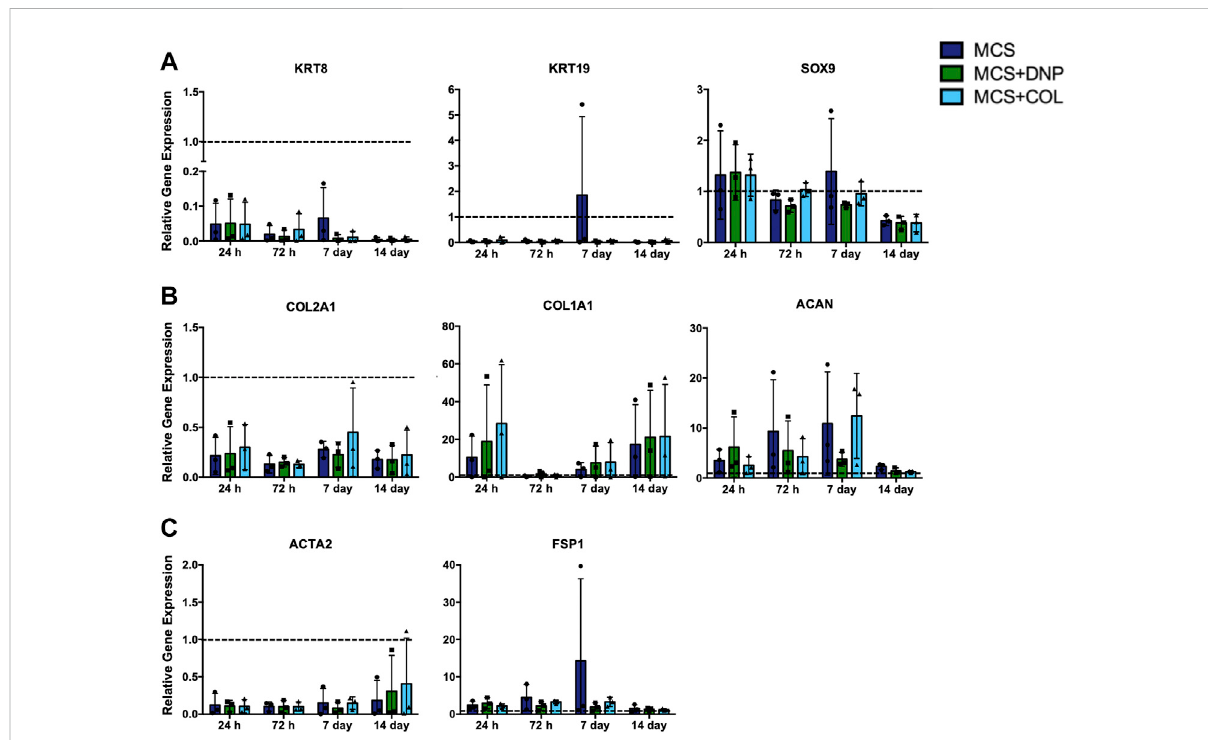
FIGURE 8 RT-qPCR geneexpressionanalysis of latepassageprimary bovine NPcells encapsulated within MCS ±DNP/COLscaffoldsand cultured in vitro up to 14 days. Late passage (P3) primary bovine NP cells were encapsulated within MCS, MCS + DNP, or MCS + COL hydrogels, and cultured in vitro for24 h,72 h,7 days,or14 days.Geneexpression analysis wasperformedtoquantifyexpression of (A) NP-associated markers( KRT8,KRT19, SOX9 ), (B) ECM genes ( COL2A1, COL1A1, ACAN ), and (C) fi broblast markers ( ACTA2, FSP1 ). Relative gene expression was determined using the ΔΔ C t methodnormalizedtoexpressionofthehousekeepinggene GAPDH ,andexpressedrelativetoP0cellsencapsulatedwithinMCSat24 h(dottedline indicated on graphs). Data is presented as mean ± SD (N = 3 p <